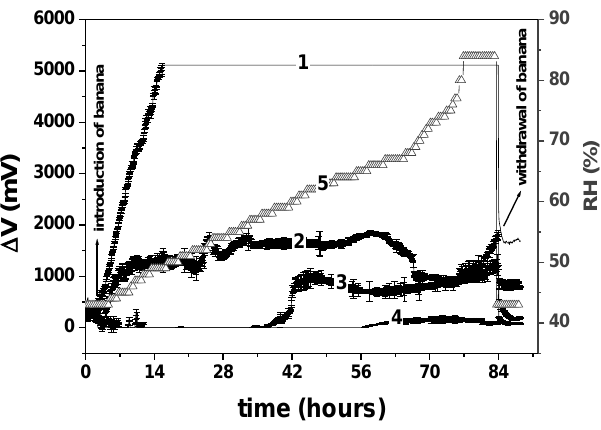
Figure 4. Average response of three arrays of sensors to the volatiles emitted during banana ripening. Each of the four sensors in the array was doped with one of the following acids: (1) HCl, (2) CSA, (3) TSA, (4) MSA and (5) relative